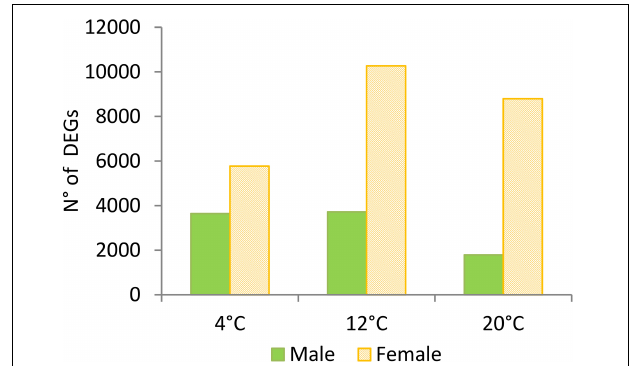
FIGURE 2 | Total number of significant differentially expressed genes (DEGs) (Deseq2, p < 0.001; log 2 FC > 2, n = 3) in Saccharina latissima gametophytes. Up-regulated DEGs in male compared to female gametophytes are indicated in green, and orange in diagonal stripes bars, respectively.